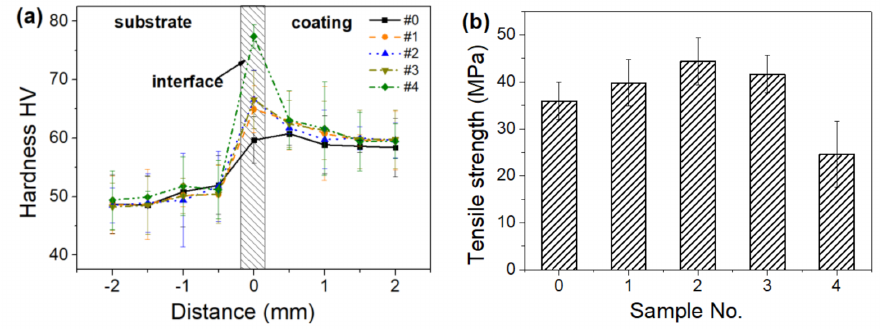
Figure 5. ( a ) Micro hardness, ( b ) bonding tensile strength of